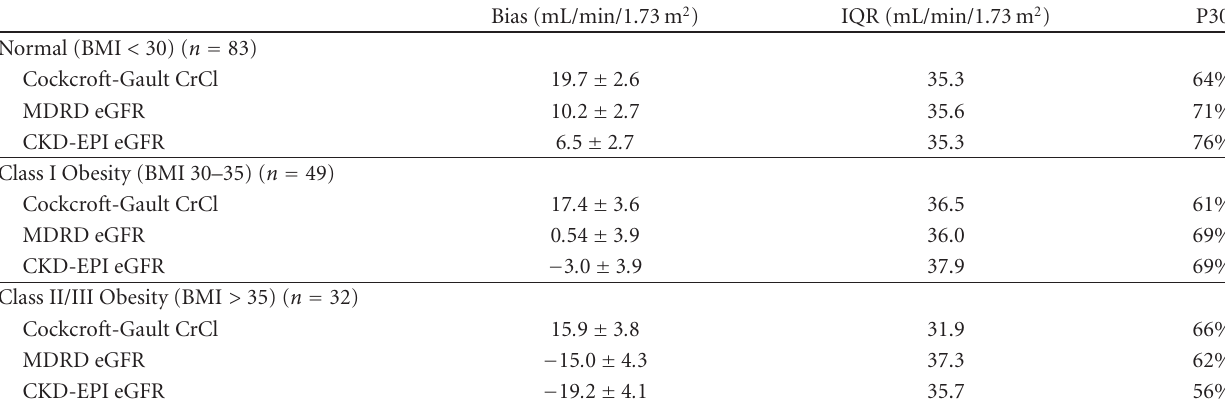
Table 2: Performance of estimating equations.